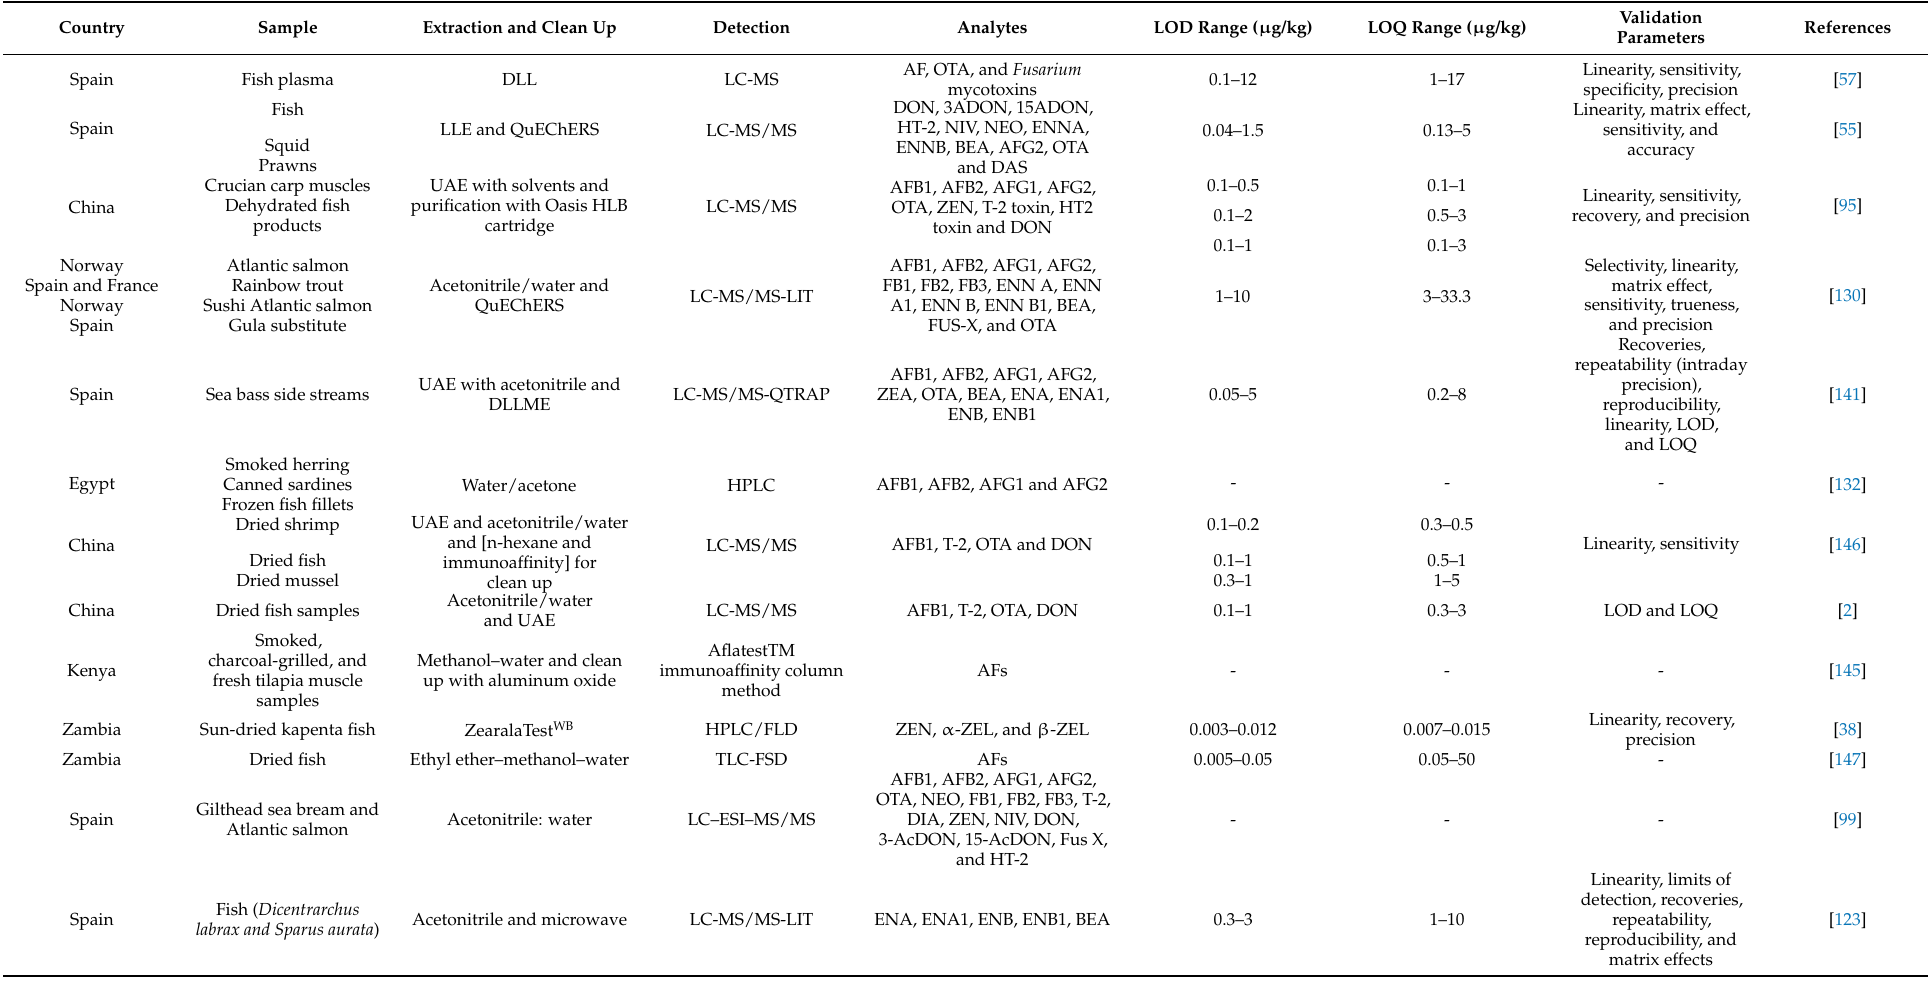
Table 2. Overview of sophisticated detection techniques to study multiple mycotoxins in